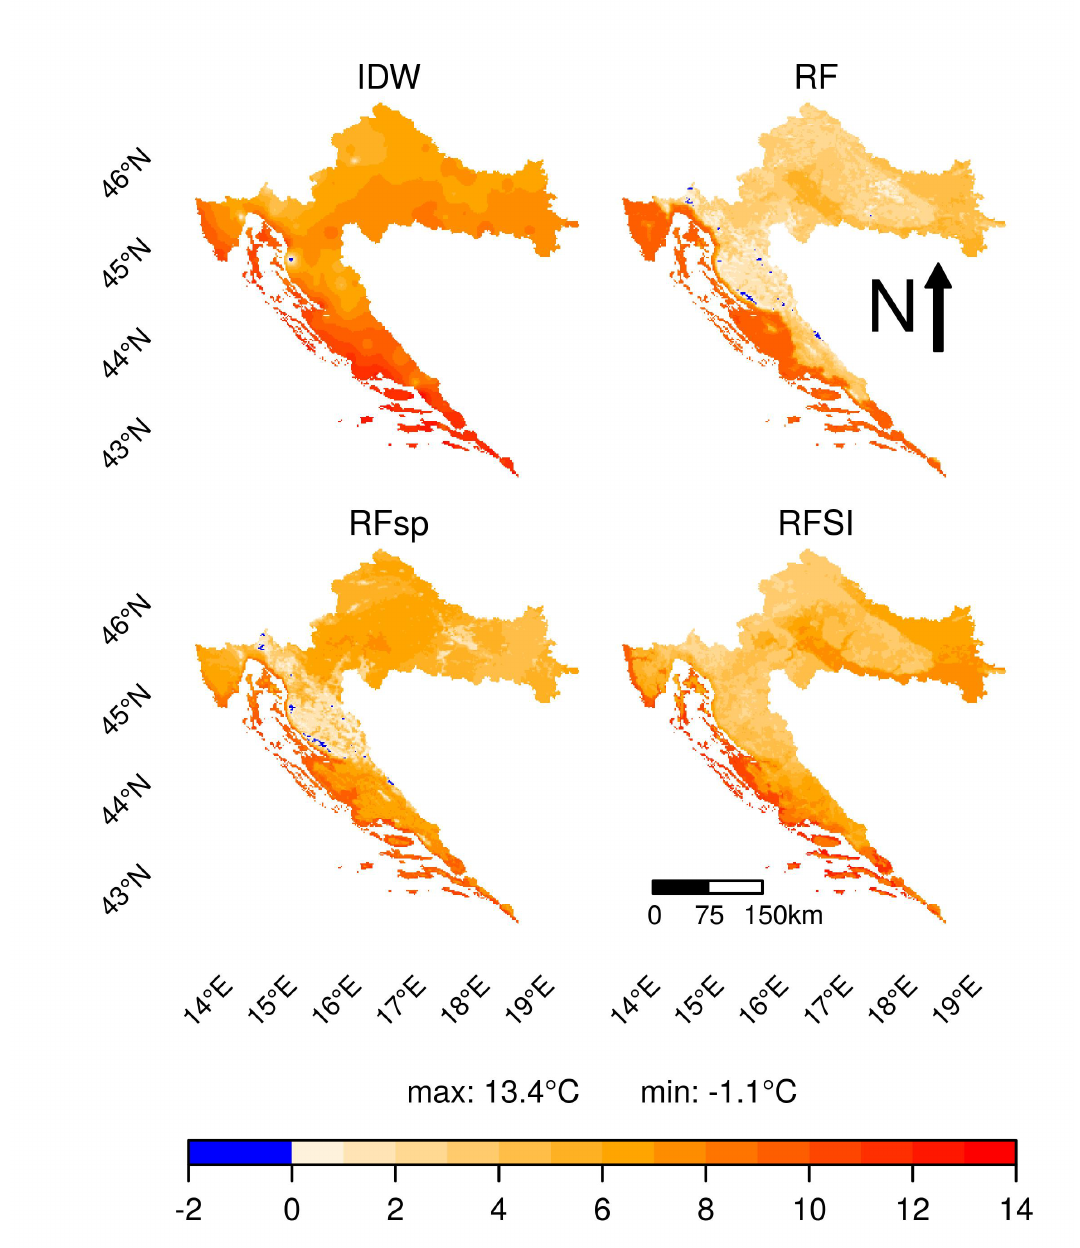
Figure 15. Prediction maps of daily temperature ( ◦ C) for the four models, for 2 February 2008. The bottom row shows the maximum and minimum observed